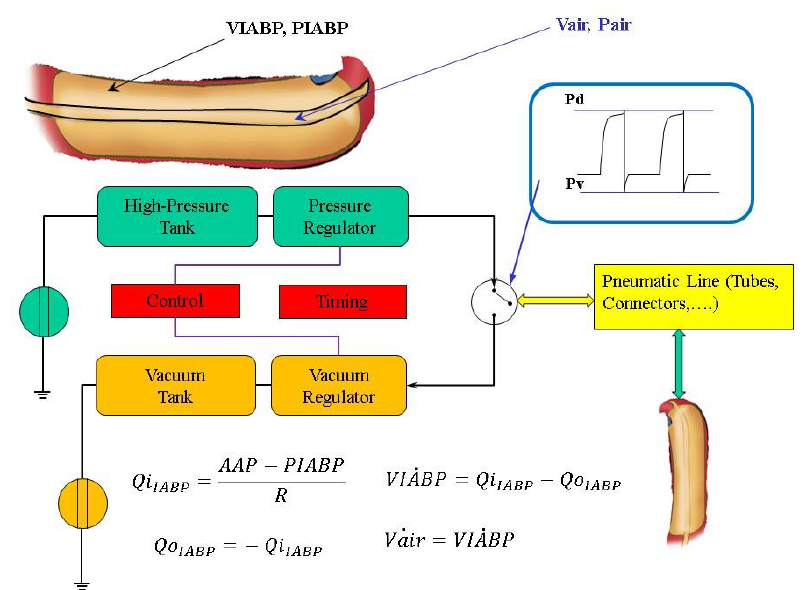
Figure 2. General layout of the driving unit of the IABP system. The air pressure waveform in the balloon is in the top right-hand corner. Pd and Pv are the driving and vacuum pressure, respectively. Qi IABP ( Qo IABP ) represents the input (output) flow source. 𝑉𝑎𝑖𝑟̇ ( Pair ) is the volume (pressure) into the part of the balloon connected to the air tube; 𝑉𝐼𝐴𝐵𝑃̇ is the balloon volume, Vmax is the maxi- ] − 760) is the balloon pressure; AAP is mum extension volume of the balloon; 𝑃𝐼𝐴𝐵𝑃 = ([ 𝑃𝑎𝑖𝑟∗760 1000 the ascending aorta pressure.